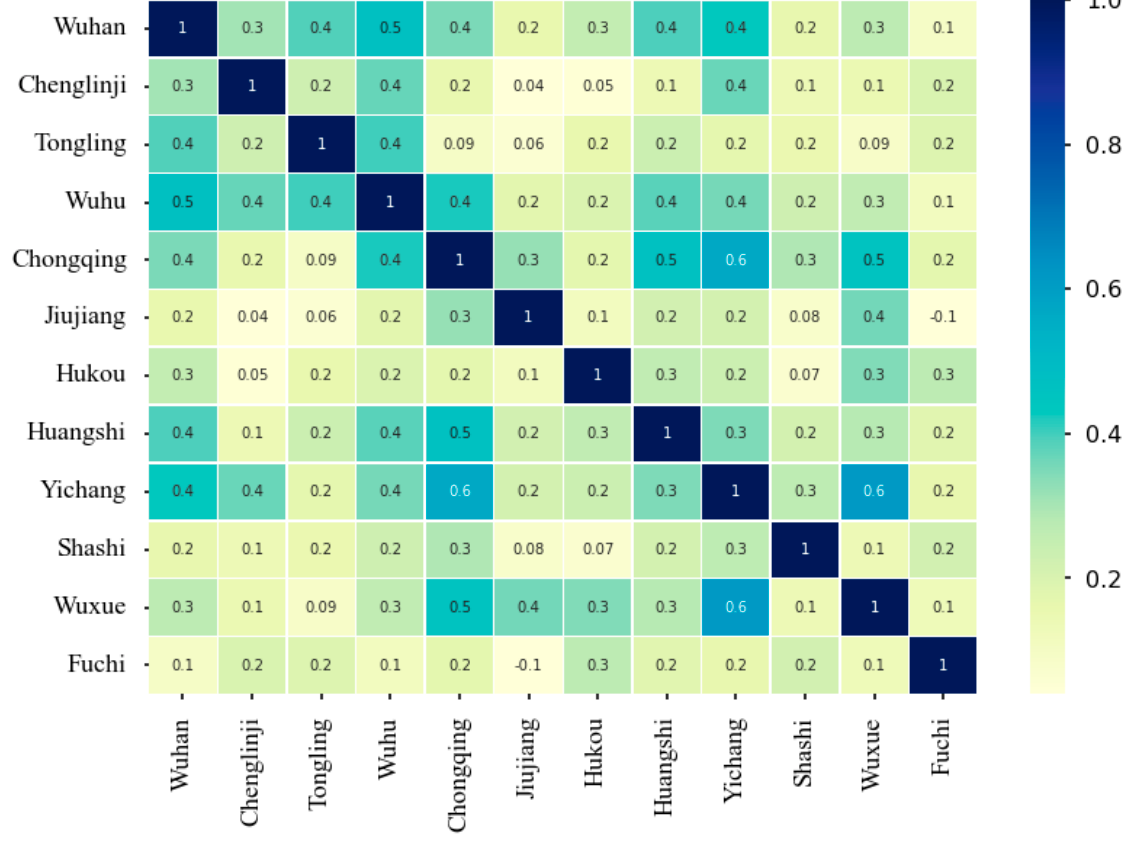
Figure 8. Heat map of Pearson correlation coefficient matrix for correlation analysis between port grade and weekly freight volume relation.